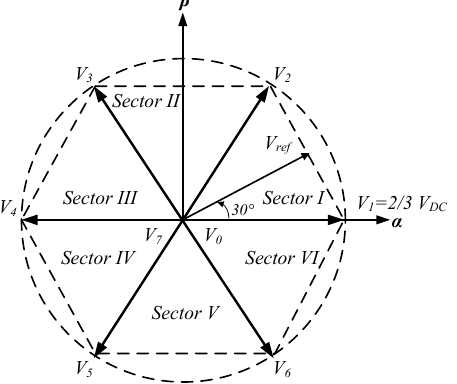
Figure 3. Space vector representation of the DCM-232